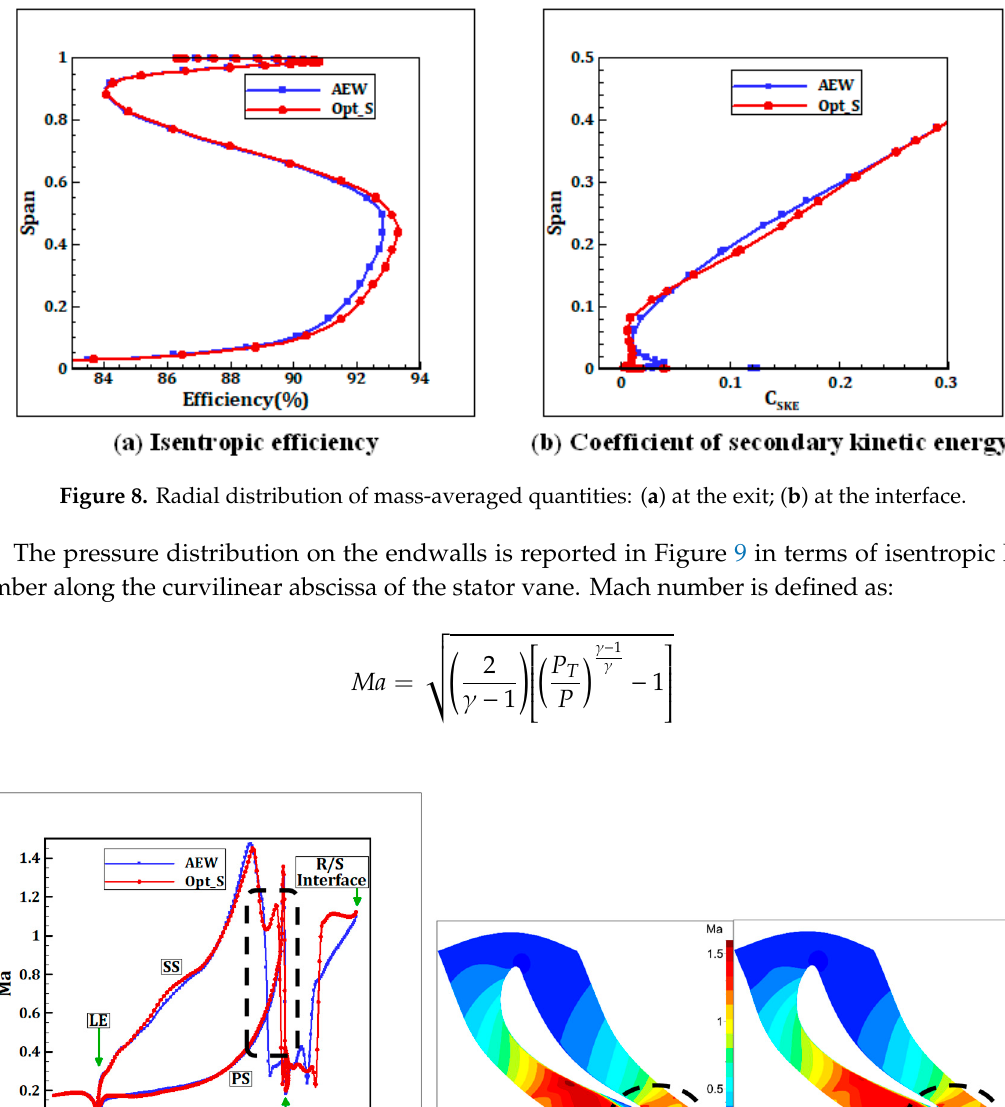
Figure 9. (a–c) Isentropic Mach number distributions and contours at 1% span.